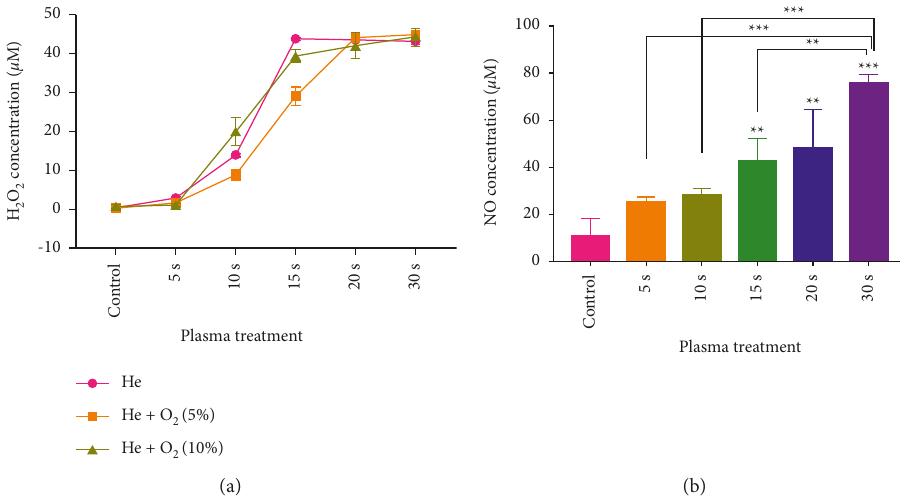
Figure 3: Extracellular H 2 O 2 and NO content. (a) The concentrations of H 2 O 2 in the cell culture medium after CAP treatment for 0 s, 5s, 10s, 15s, 20 s, and 30s. (b) The concentrations of NO in the cell culture medium after CAP treatment for 0s, 5 s, 10s, 15s, 20s, and 30s. Data represent the mean SD of three independent experiments. control. ±